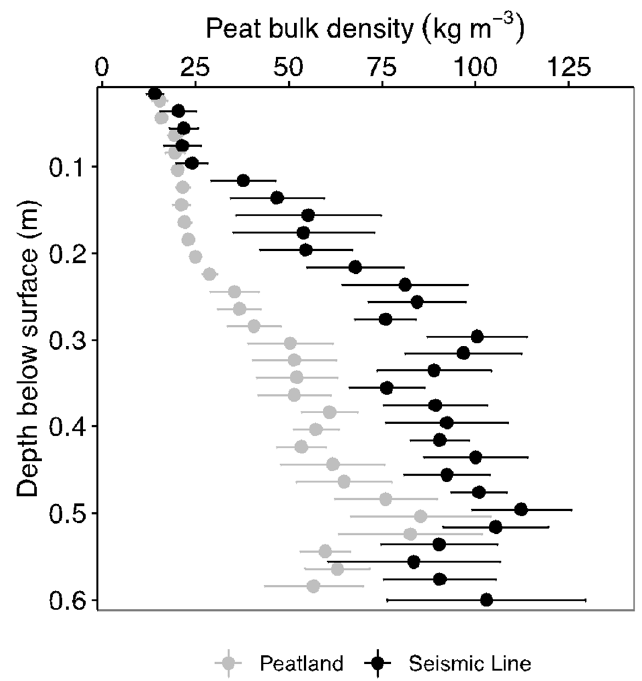
Figure 4. Peat bulk density averaged by 0.02 m depth intervals for seismic line ( n = 6) and adjacent peatland ( n = 6) cores.